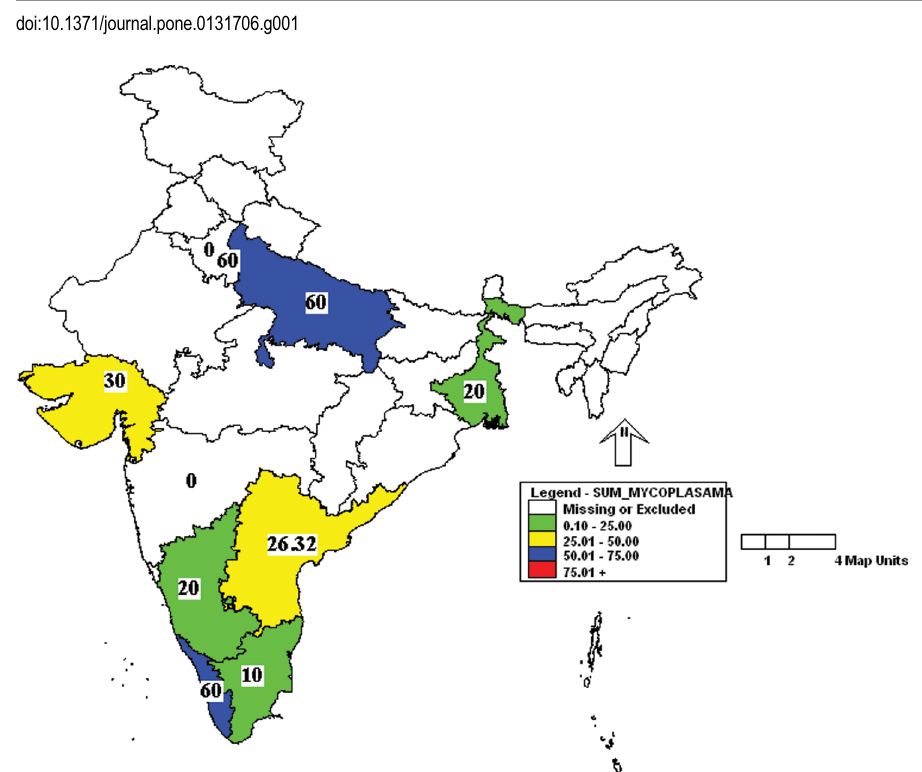
Fig 2. Incidence of Mycoplasma pulmonis in different states of India. Green — 00.00 to 25.00%; Yellow — 25.01 to 50.00%; Blue — 50.01 to 75.00%.